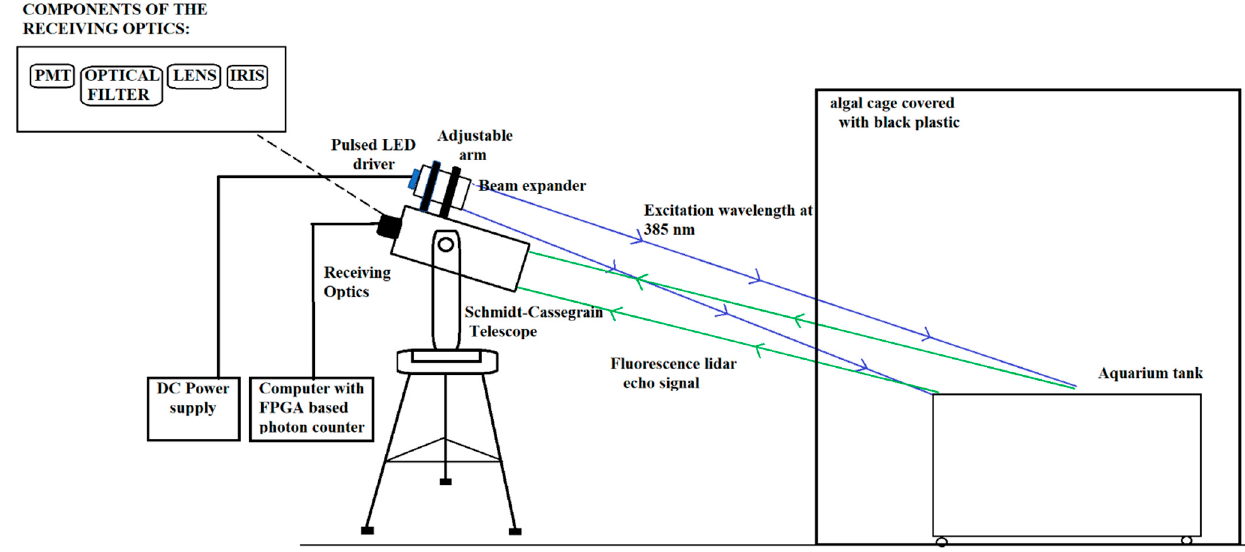
Figure 2. Schematic diagram of the pulsed LED fluorescence lidar system.